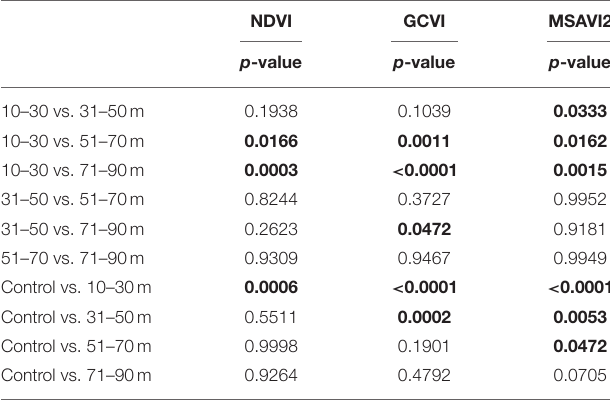
TABLE 5 | P -values resulting from Tukey’s range test between the distances classes from linear mixed effect models for each vegetation